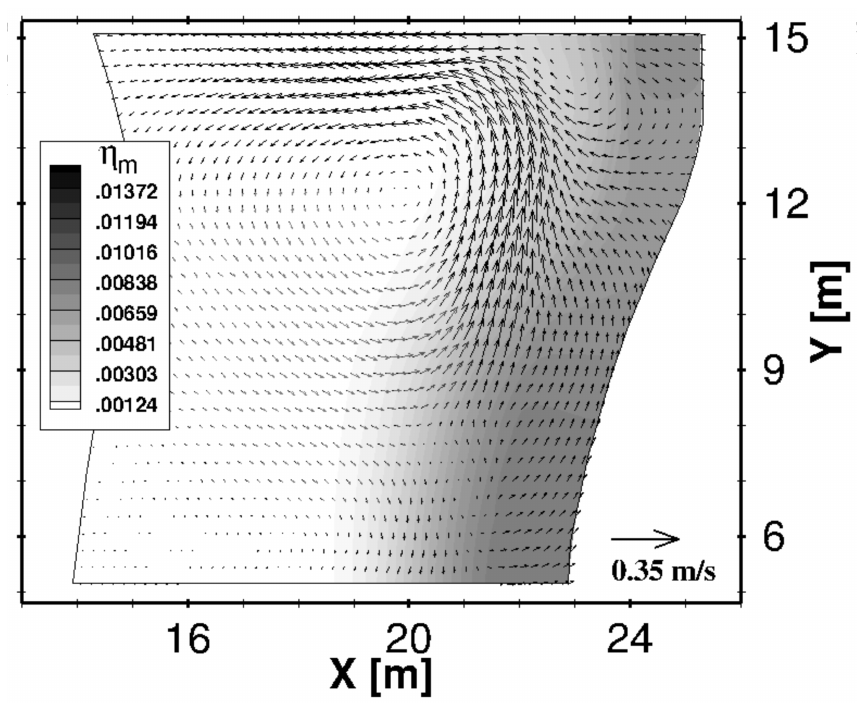
Figure 3. Plan view detail of the time averaged (over 120 wave periods) velocity field. Only one out of every four vectors is